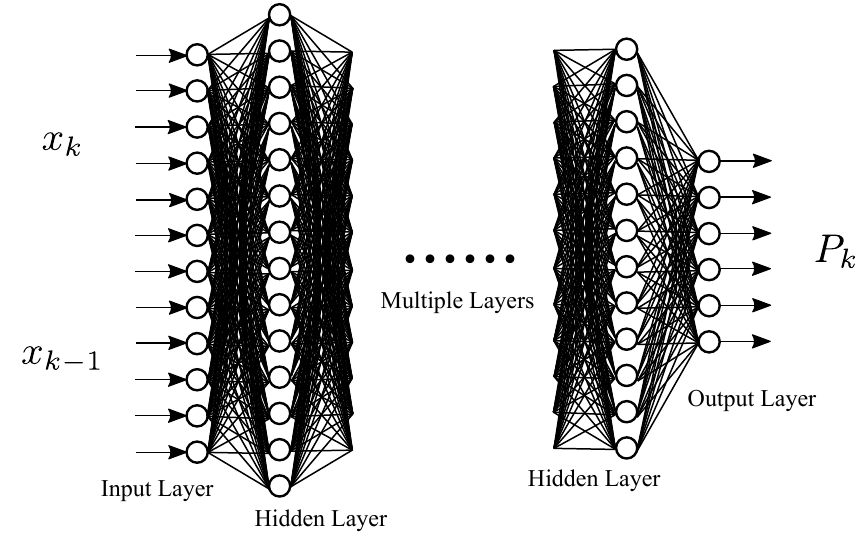
Figure 7. The architecture of the deep